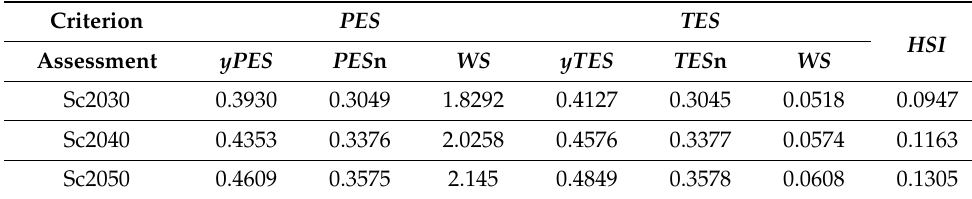
Table 2. Scenario modeling for EECCA